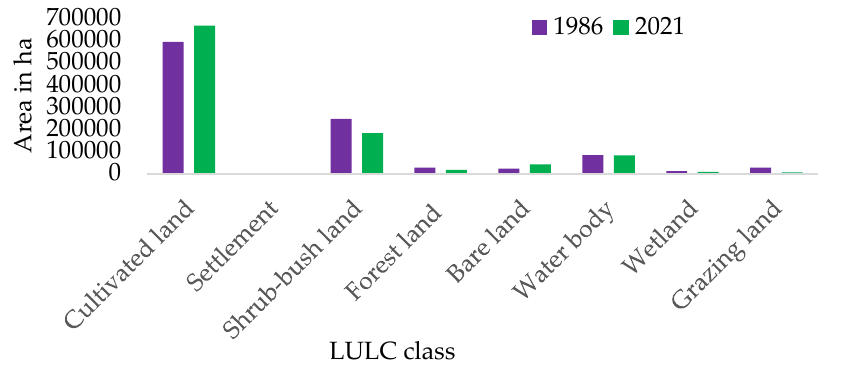
Figure 7. Changes in LULC from 1986 to 2021 in Chilalo mountain, Ethiopia. (Source of data: Biratu et al. [71], but figure done by